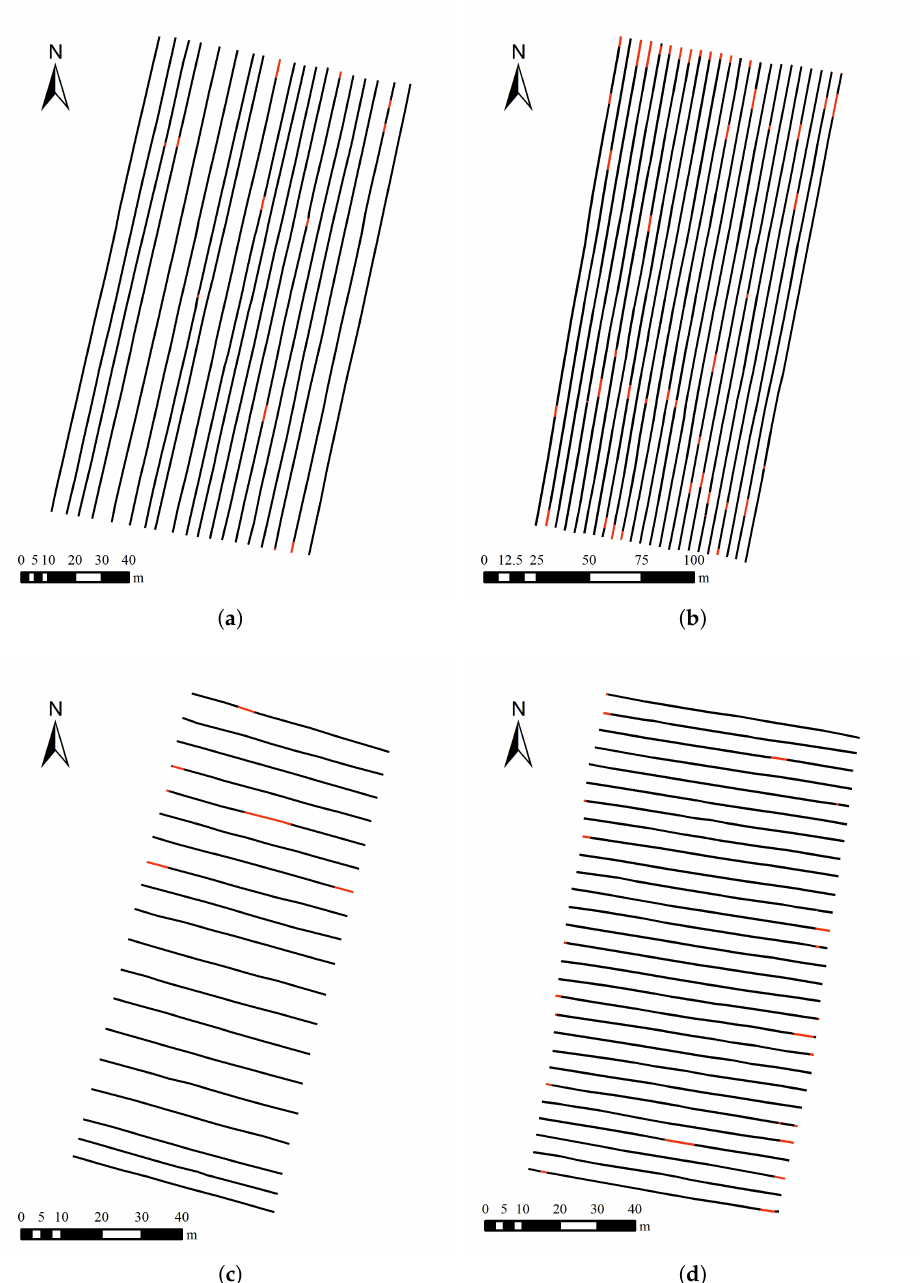
Figure 14. Ridge detection assessment result. True positives (TP) are black and false positives (FP) are red. ( a ) Plot 1, ( b ) Plot 2, ( c ) Plot 3, ( d ) Plot